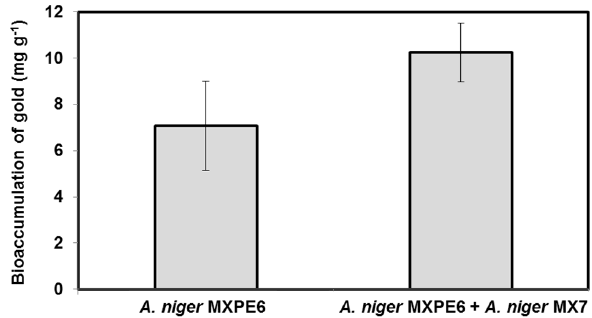
Figure 6. Accumulation of gold in the fungal biomass of PCB treatments. Data are given as means ± standard error; n = 3.